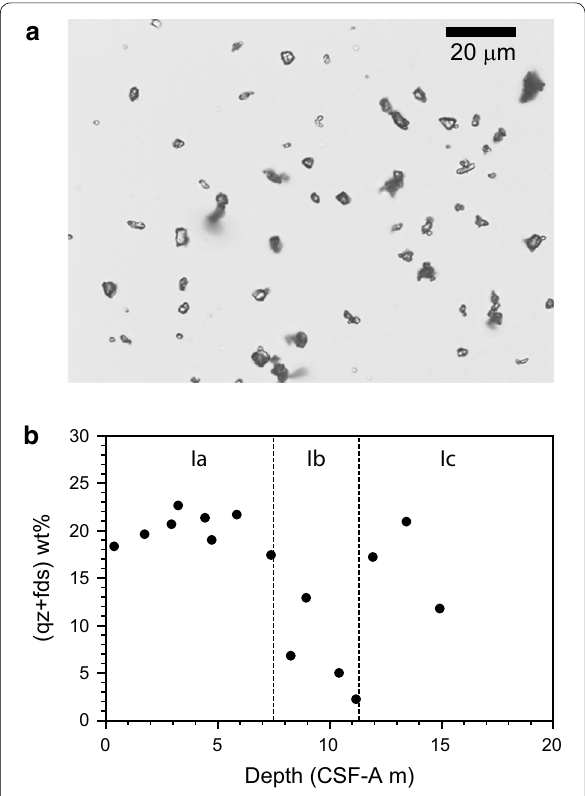
Fig. 2 a Representative optical microscope image of the quartz feldspars separate from sample from 0.37 CSF-A m. b Depth variation of the mass fraction of the quartz and feldspars separate. Vertical dashed lines represent lithostratigraphic unit